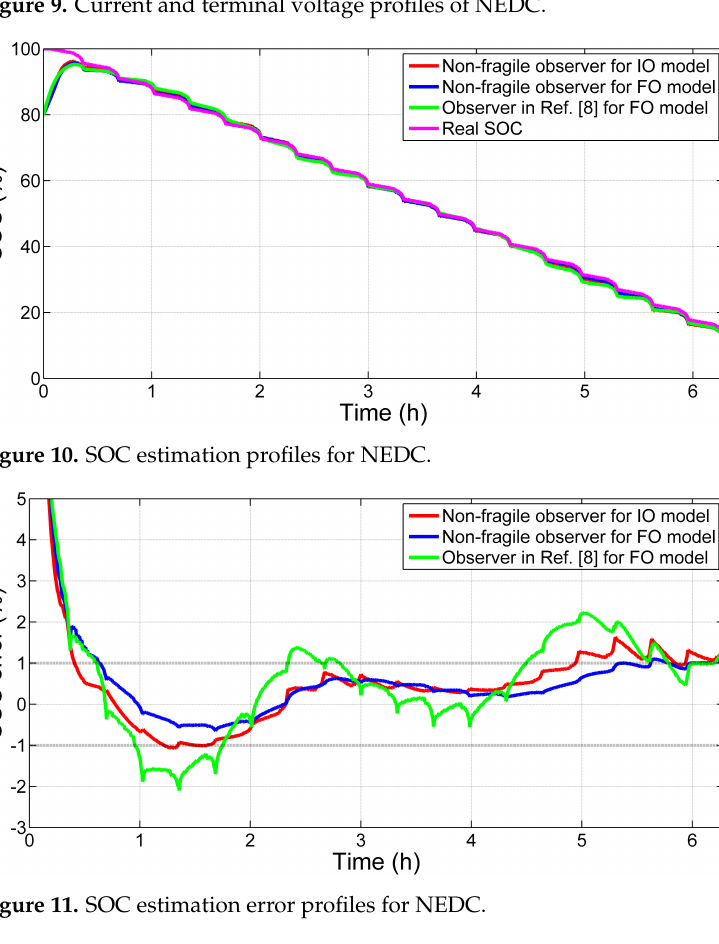
Figure 9. Current and terminal voltage profiles of NEDC.